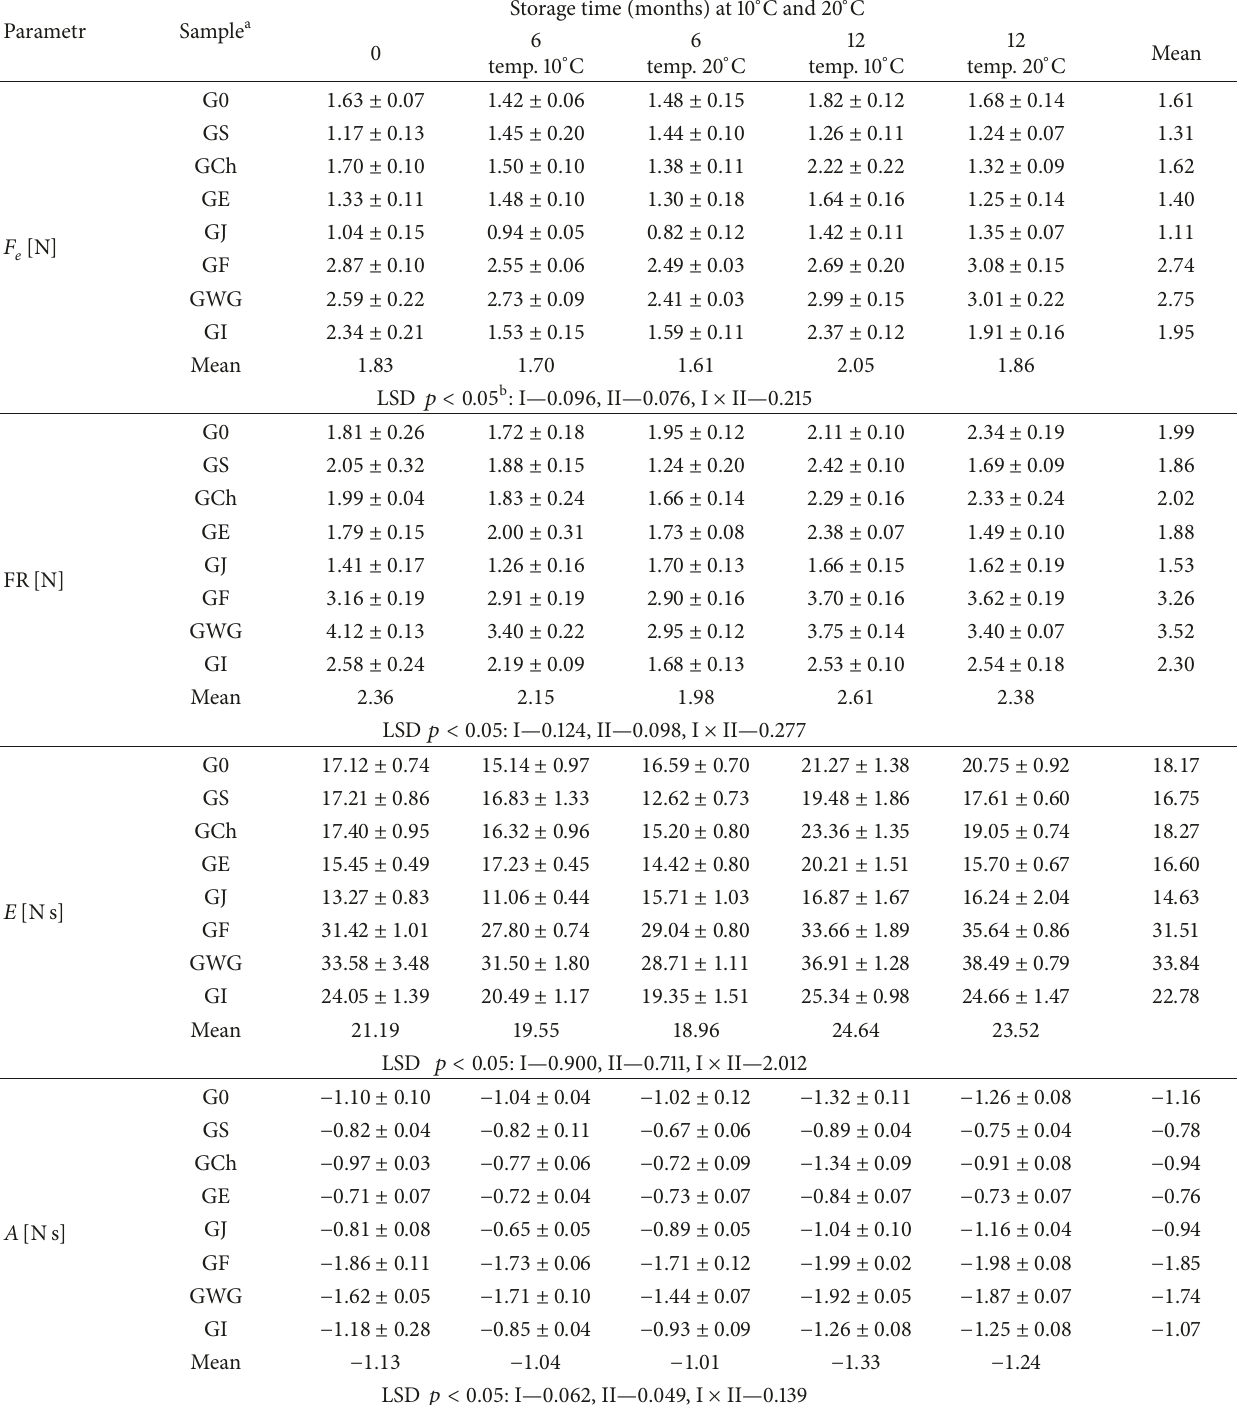
Table 2: Changes in texture parameters of gooseberry jam during storage in 10 ∘ C and 20 ∘ C.